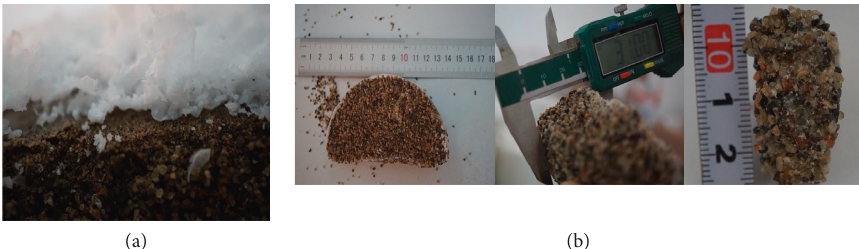
Figure 6: Heterogeneous column after the experiment. (a) The salt crust was elevated and formed salt domes. (b) The salt precipitated below the surface of coarse